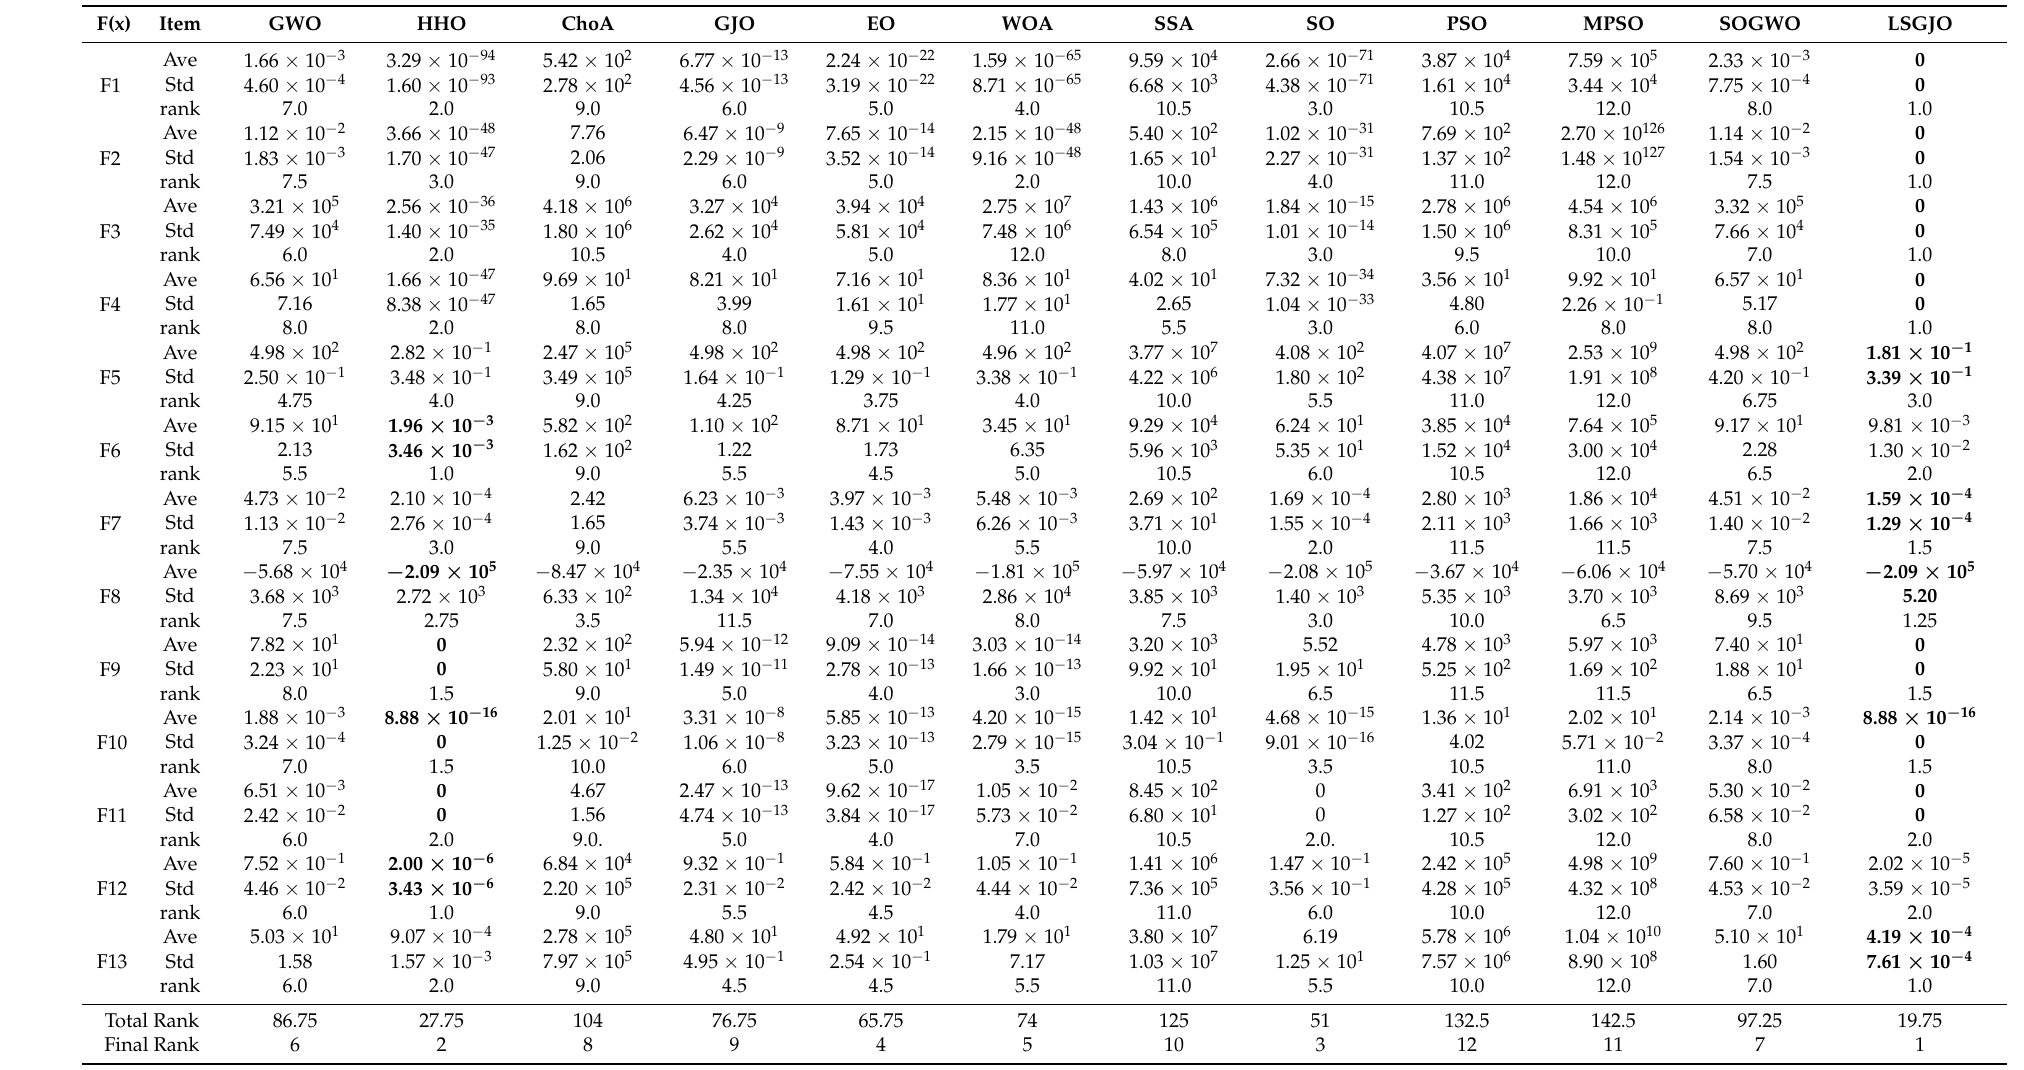
Table 5. Results and comparison of different algorithms on 13 benchmark functions with Dim = 500. The best results of the experiments are shown in